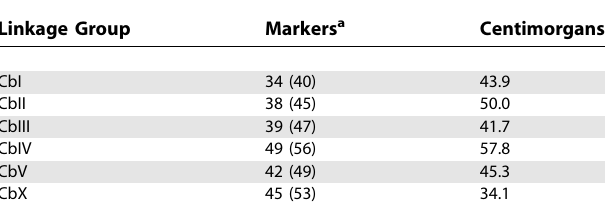
Table 2. The 247 Markers Fall into Six Linkage Groups Linkage